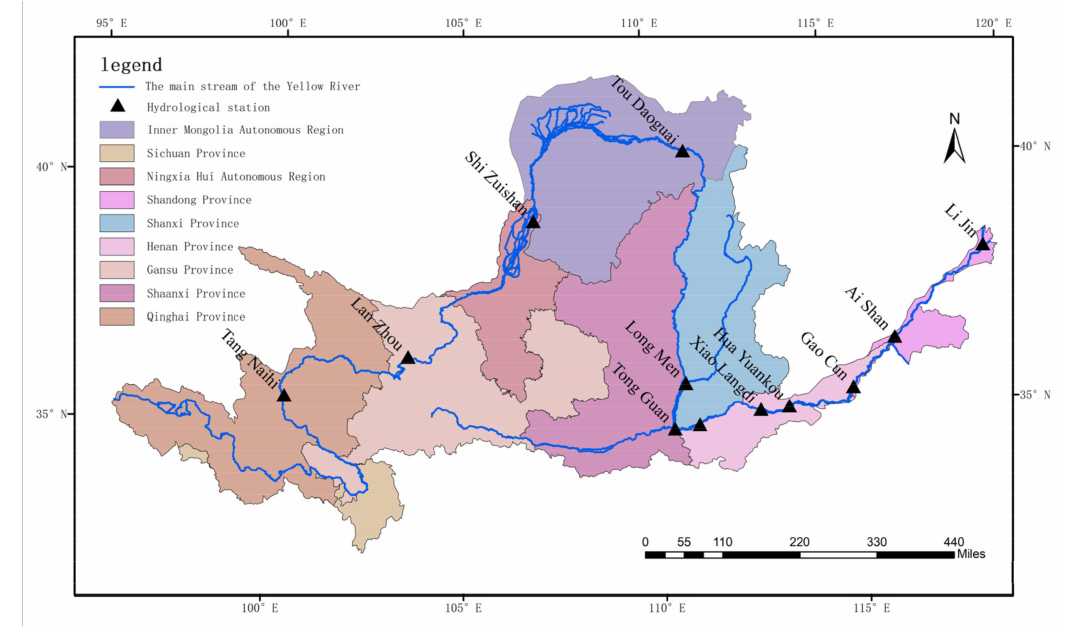
Figure 1. Overview of the study